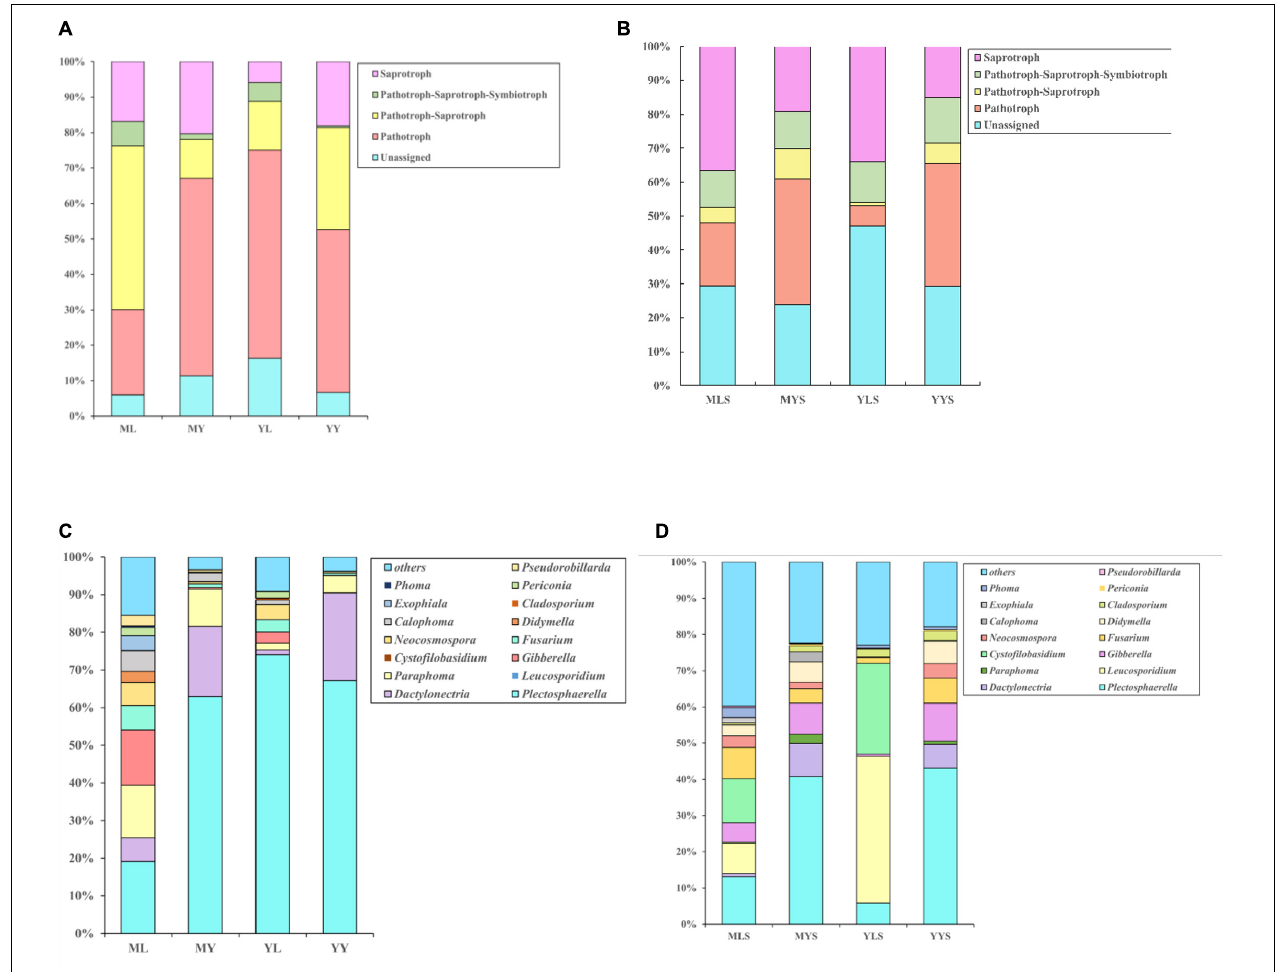
FIGURE 10 | (A) Annotation on the community function of endophytic fungi. (B) Annotation on the community function of the rhizosphere. (C) Bar diagram of endophytic fungi community of L. chuanxiong for controlling. (D) Bar diagram of rhizosphere community of L. chuanxiong for controlling. ML refers to Lingzi under M-Y cultivation modes; YL refers to Lingzi under Y-Y cultivation modes; MY refers to Chuanxiong under M-Y cultivation modes; YY refers to Chuanxiong under Y-Y cultivation modes; MLS refers to the soil of Lingzi under M-Y cultivation modes; YLS refers to the soil of Lingzi under Y-Y cultivation modes; MYS refers to the soil of Chuanxiong under M-Y cultivation modes; YYS refers to the soil of Chuanxiong under Y-Y cultivation